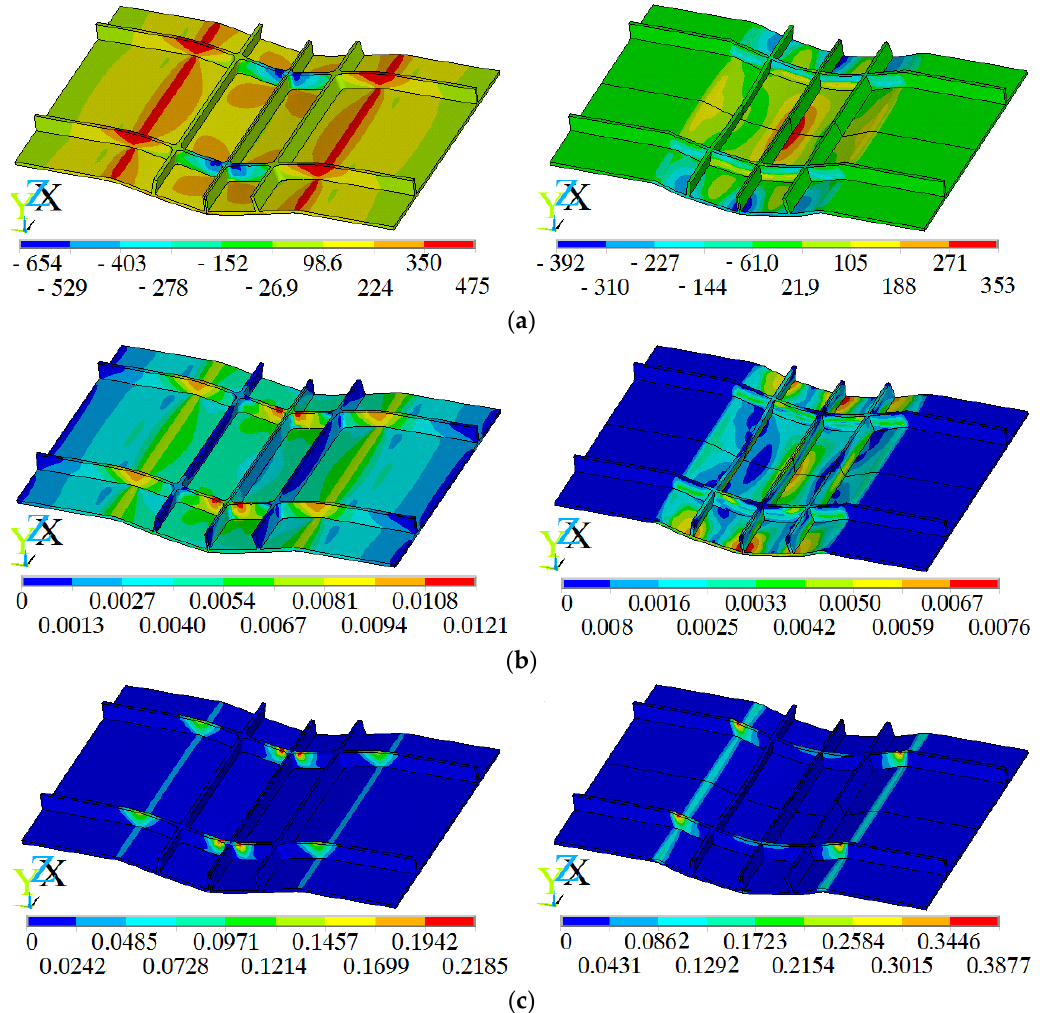
Figure 22. Comparison of simulated results between BF (left) and EMF (right): ( a ) σ y (MPa); ( b ) equivalent elastic strain; and ( c ) equivalent plastic strain.